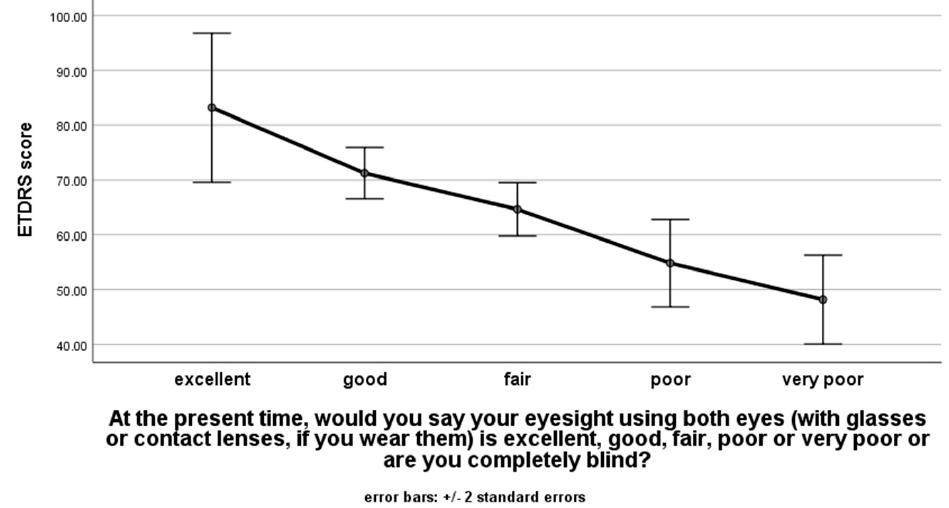
Figure 5. ANOVA analysis of the best corrected visual acuity of the right eye (BCVA.OD) with ETDRS letter scores in comparison with their self-estimated visual acuity from the answer to the question “At the present time, would you say your eyesight using both eyes (with glasses or contact lenses, if you wear them) is excellent, good, fair, poor or very poor or are you completely blind?” Error bars with ± 2 standard